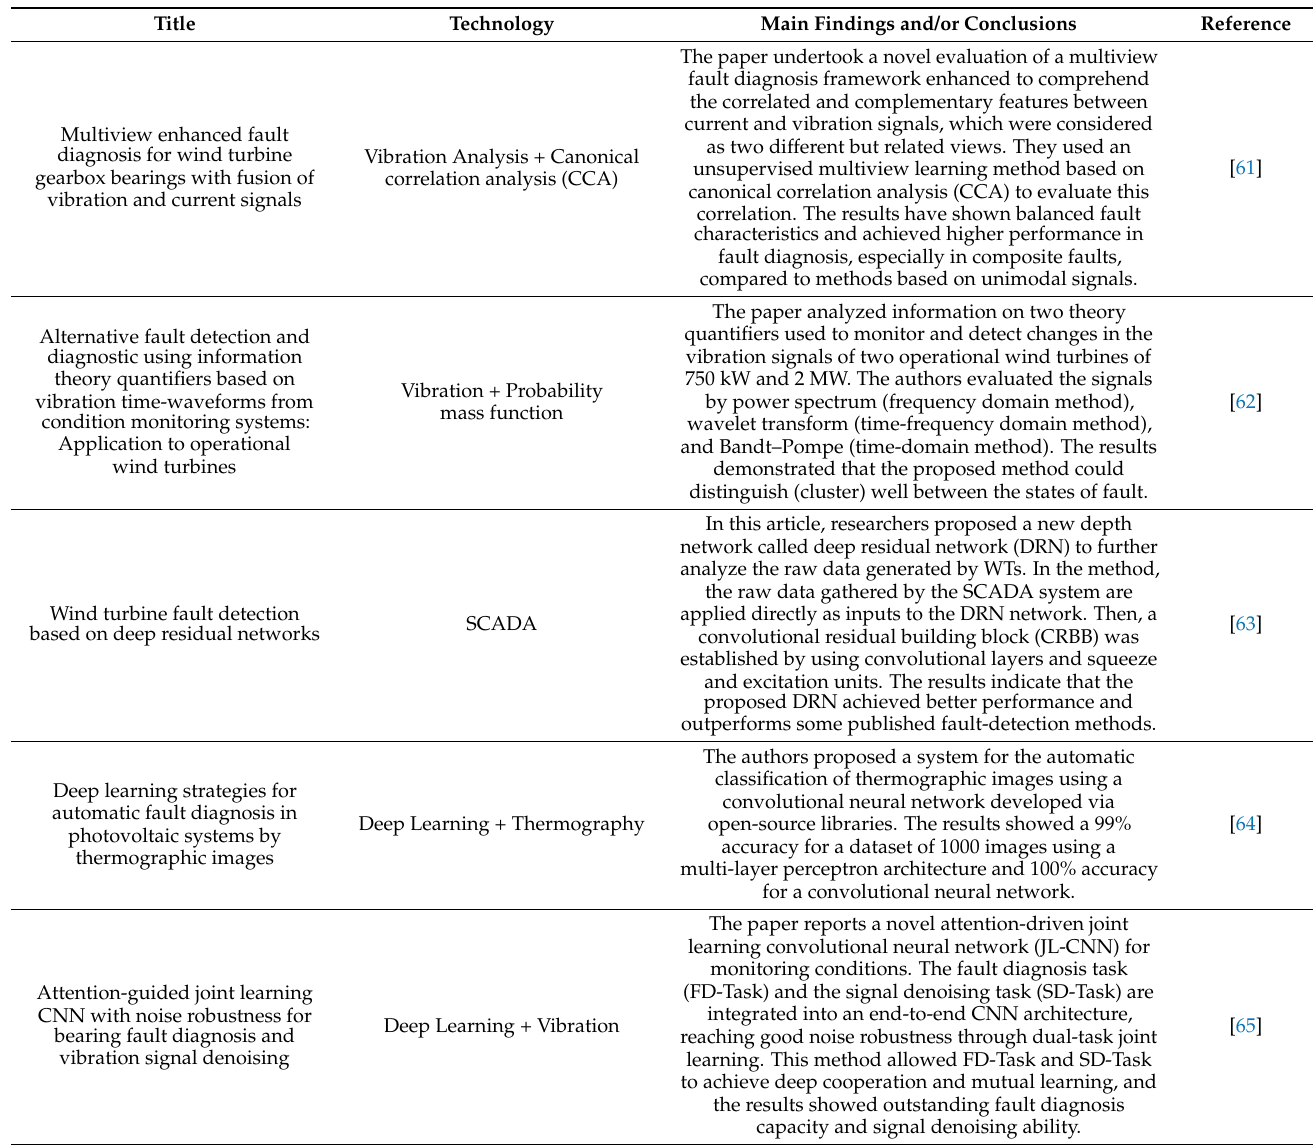
Table 2. Articles that focus on the use of condition monitoring (CD) and nondestructive testing (NDT) for fault diagnosis on Wind